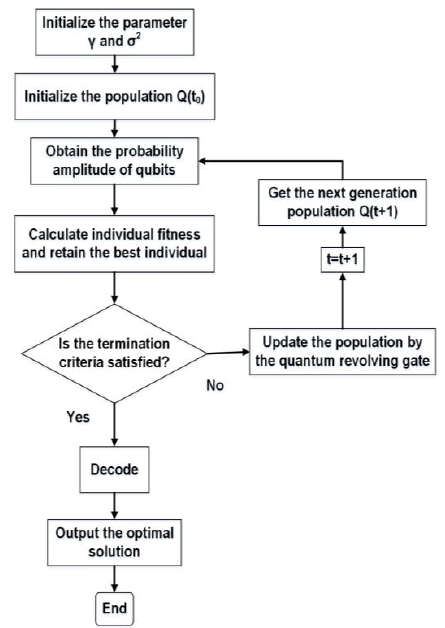
Figure 2. The flow chart of the Least Squares Support Vector Machine (LSSVM) optimized by quantum genetic algorithm (QGA).